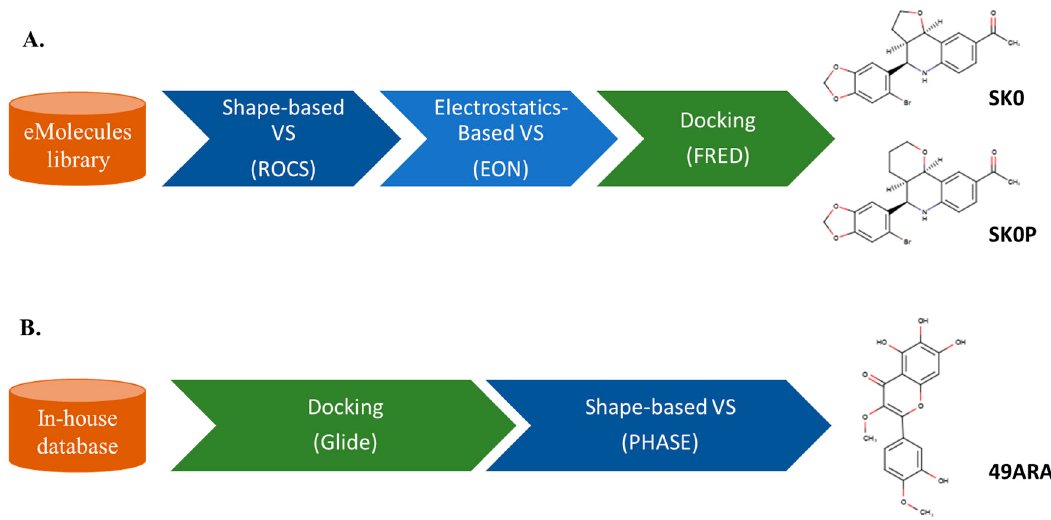
Figure 3. Schematic representation of two sequential VS processes (LB and SB methods are highlighted in blue and green, respectively). ( A ) Sequential application of LB (shape-based and electrostatic-based similarity search) followed by SB (docking). The two most active compounds found, SK0 and SK0P, exhibited antiproliferative activities against SK-BR-3 and MCF7 cell lines in the micromolar range. ( B ) Sequential VS of SB followed by LB over an in-house database. The compound 49ARA was detected among the top-ranked compounds included in the methylene chloride extract of Artemisia annua (IC 50 of 2.2 µ g / mL). ROCS: Rapid Overlay of Chemical